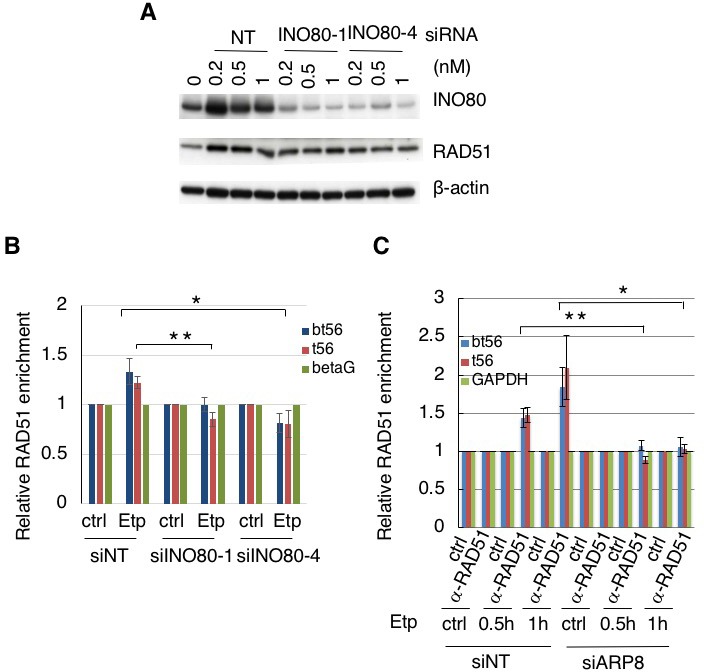
Requirement of INO80 and ARP8 for RAD51 binding to the BCR of the MLL gene.(A) Immunoblotting analysis of INO80 depletion efficiency. Two kinds of siRNAs against INO80 were used for the detection of the INO80 knockdown efficiency. RAD51 expression did not affect the INO80 knockdown. β−actin was used as the loading control. (B) ChIP analysis of the enrichment of RAD51 in AT5BIVA cells treated with non-targeting siRNA (siNT) or the siRNAs against INO80 (siINO80-1 and siINO80-4). The cells were treated with etoposide for 15 min, washed, and then cultured in fresh medium for 1 hr (Etp). Vehicle treatment was performed as a control. The DNA was analyzed by real-time PCR, using the MLL BCR gene primers. The β−globin gene (betaG) was used as a control region. Values represent the means ± SE from six independent experiments. *p<0.05. Source data are presented in Figure 4—source data 2. (C) ChIP analysis of RAD51 loading onto the MLL BCR, in AT5BIVA cells transfected with the non-targeting siRNA (siNT) or siARP8. The cells were treated with DMSO (ctrl) or etoposide for 15 min, washed, and then cultured in fresh medium for 30 or 60 min. GAPDH is shown as the control region. Values represent the means ± SE from four independent experiments. *p<0.05, **p<0.01. Source data are presented in Figure 4—source data 2.